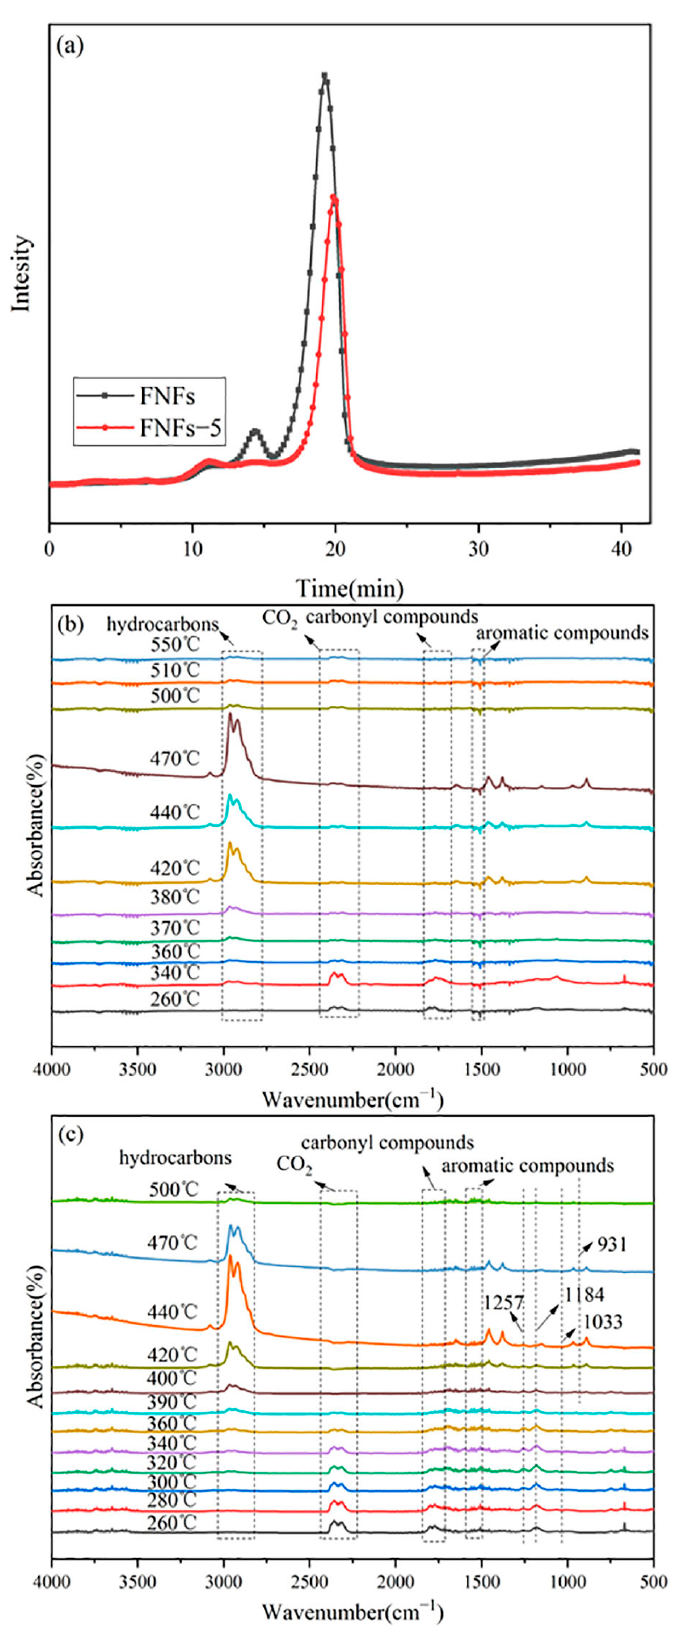
Figure 9. ( a ) Volatile pyrolysis products of the FNFs and FNFs-5, ( b ) FTIR spectra of the pyrolysis products of the FNFs, and ( c ) FNFs-5 at di ff erent temperatures.